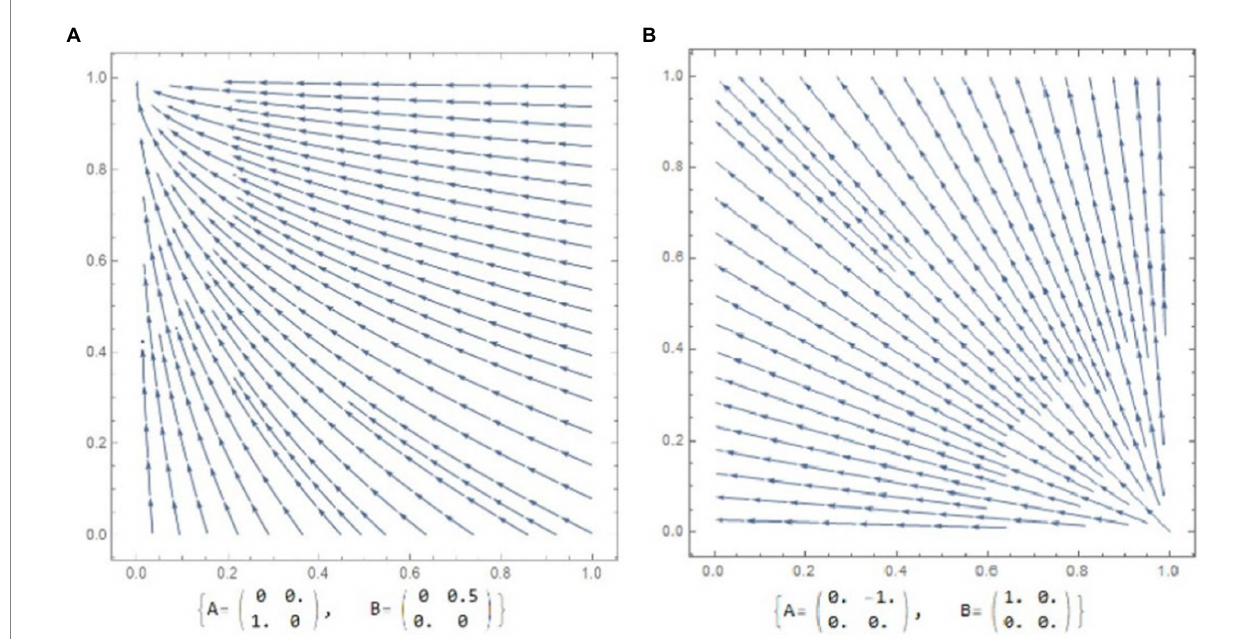
FIGURE 1 Phase portrait and corresponding payoff matrices for males and females. The arrowheads depict evolutionary trajectories. (A) An evolutionary dynamic directed toward female-only care. (B) An evolutionary dynamic where male population would be specifically selected against male-only care.